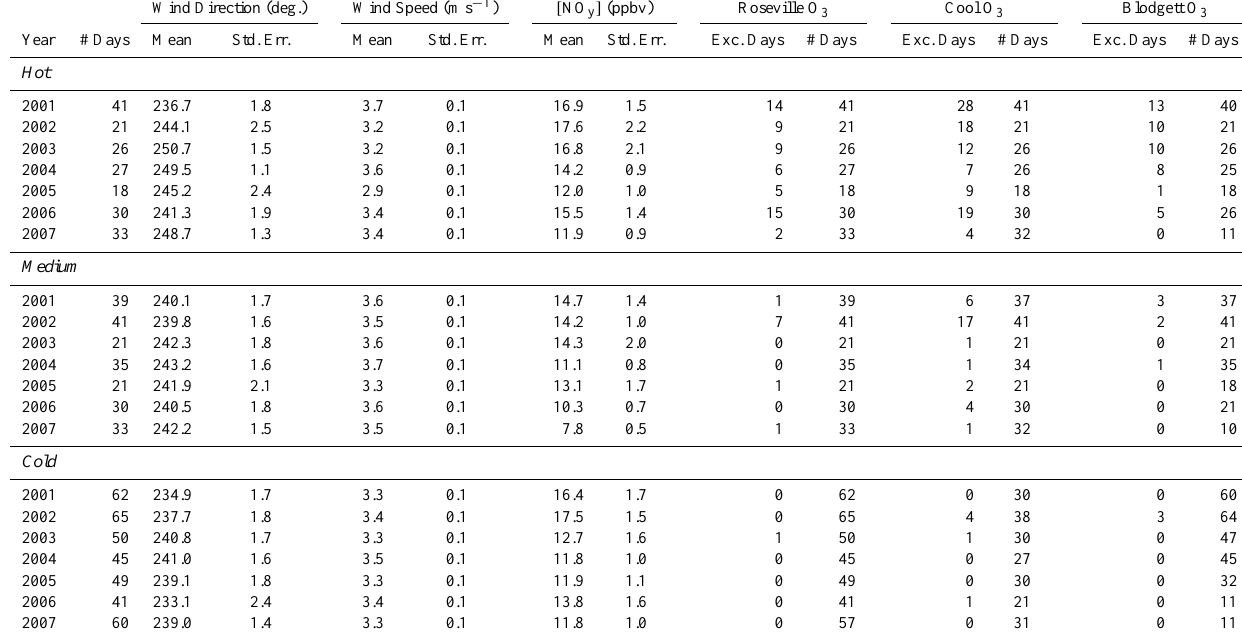
Table 2b. Relaxed Filter (May–September). Wind Direction